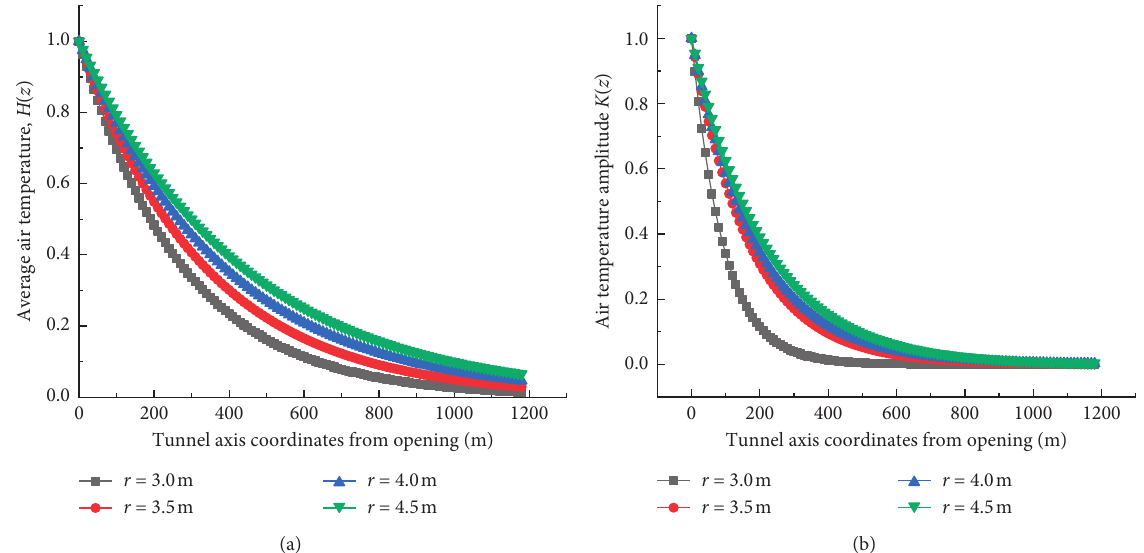
Figure 5: Variation of longitudinal direction temperature function with different tunnel radii: (a) the average air temperature function, H ( z ), under tunnel length; (b) the air temperature amplitude function, K ( z ), under tunnel length.